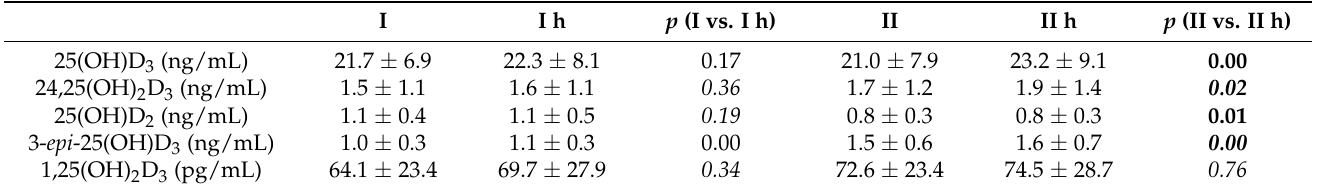
Table 2. Changes in vitamin D metabolite levels after exercise before and after fasting.